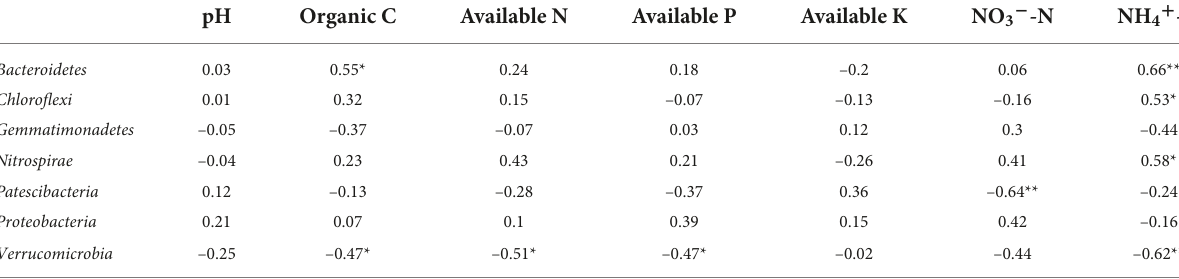
TABLE 5 Pearson’s correlation coefficients between abundant phyla and soil physicochemical properties.